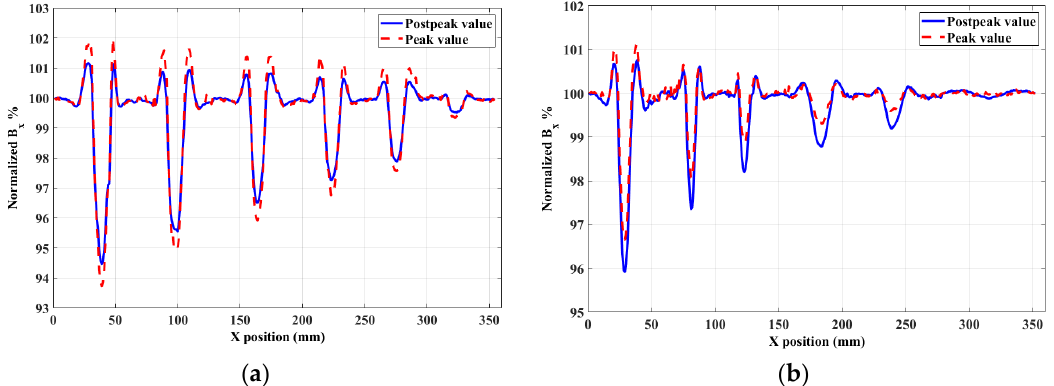
Figure 9. Line scanning results of ( a ) surface and ( b ) reverse defects.